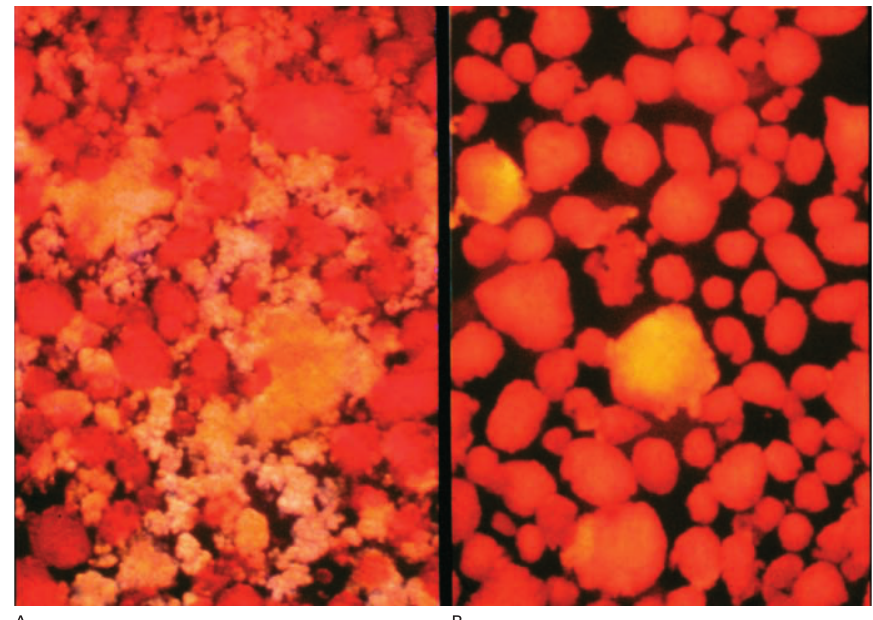
Figure 2 Isolated human islets of Langerhans. (A) Unpurified islets, stained in red by dithizone (x100), are surrounded by exocrine tissue. (B) Purified islets of over 90%